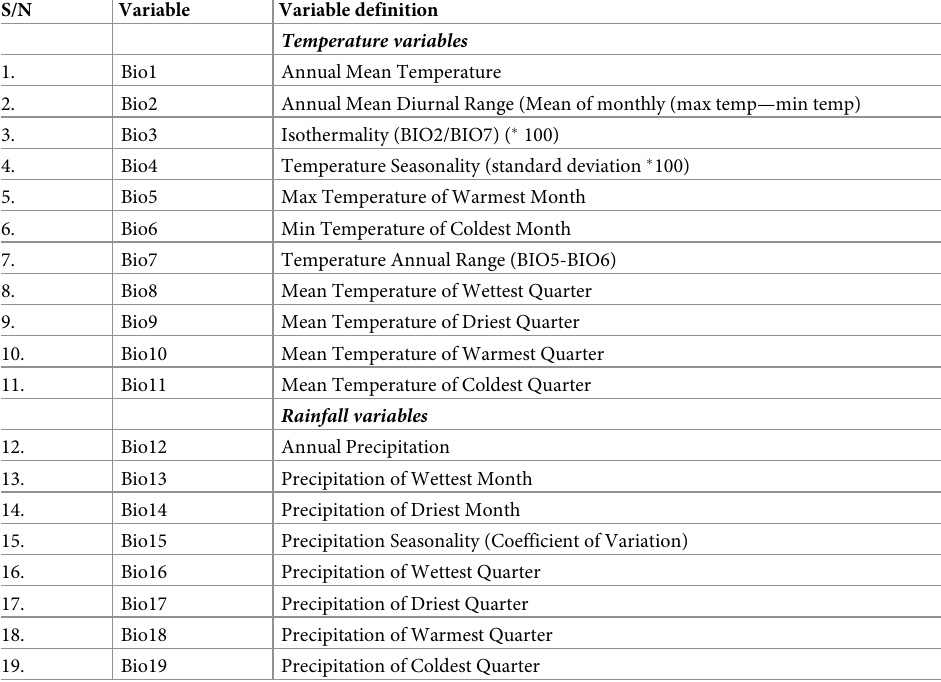
Table 1. Bioclimatic predictor variables used for modeling suitable environmental conditions influencing anthrax distribution in QEPA. S/N Variable Variable